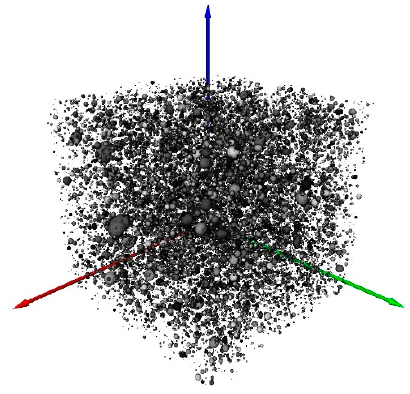
Figure 5. Pores identified and isolated.